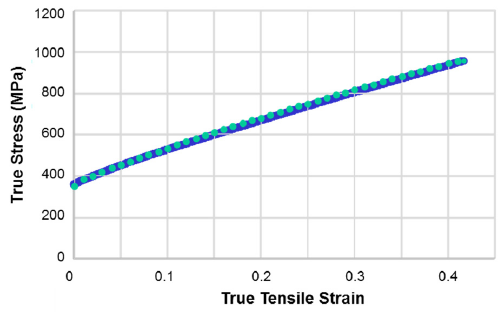
Figure 3. Tensile stress-strain curve of the TWIP steel in initial condition before ECAP, tested in RD of hot rolling. Continuous line: experiment, dotted line: simulation. The experiment was performed at a strain rate of 10 − 3 s − 1 at room temperature.